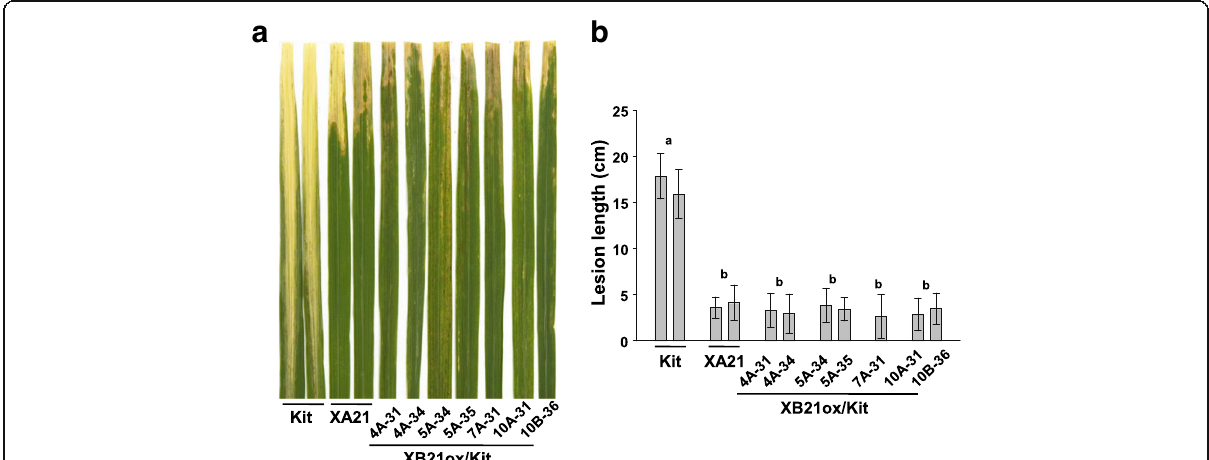
Fig. 3 Kitaake wild type rice plants overexpressing XB21 (XB21ox/Kit) exhibit enhanced resistance to Xoo . a Rice plants 14 days after inoculation with Xoo . From left to right: Kitaake wild type (Kit), transgenic line (XA21, 23A-1-14) carrying XA21 driven from its native promoter, and transgenic Kitaake lines carrying XB21ox construct (XB21ox/Kit). b Lesion lengths of Xoo inoculated plants of Kitaake wild type (Kit), transgenic line (XA21)